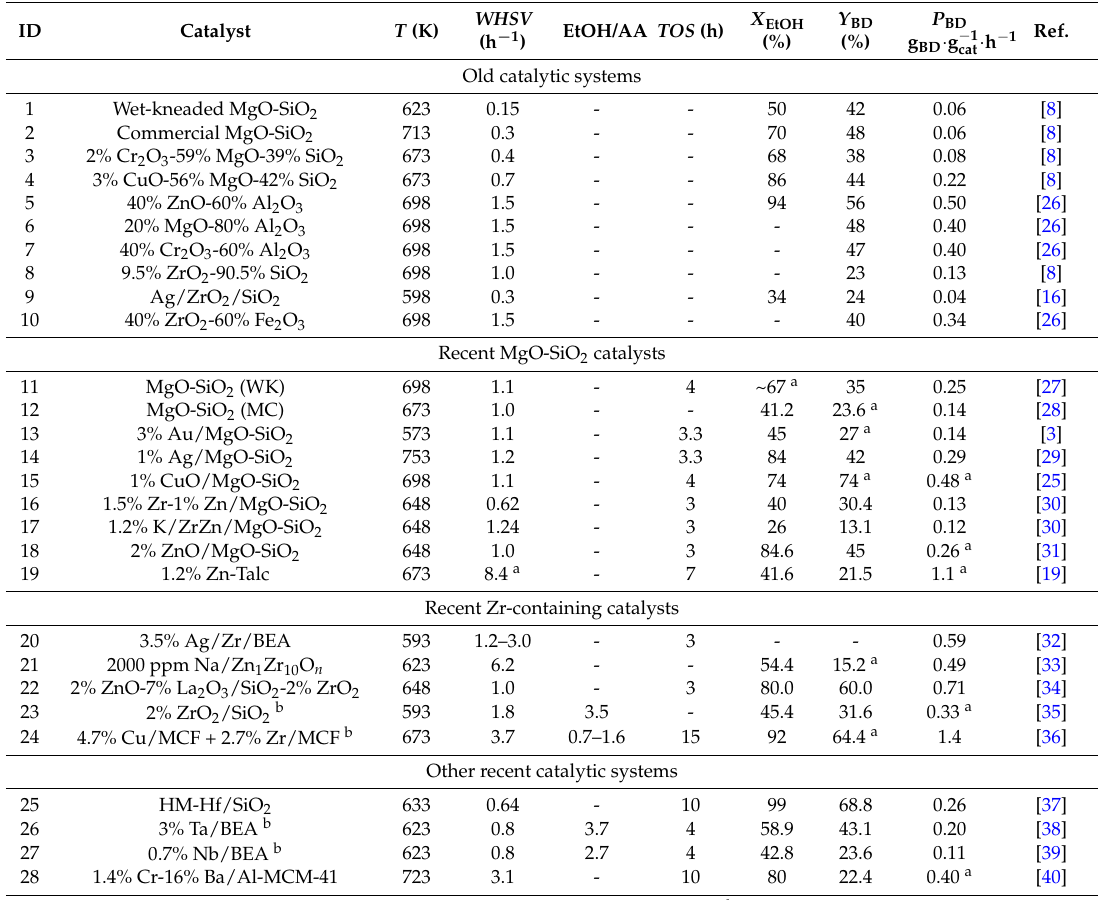
Table 1. Catalytic performances of selected materials of the literature, including the best performing catalysts found in the articles reviewed in this